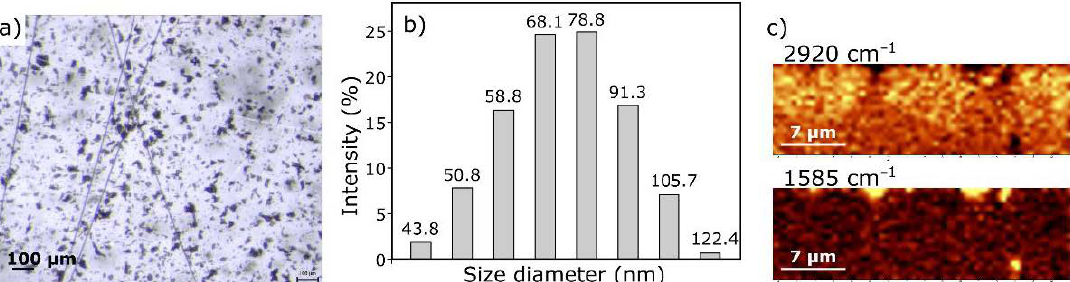
Figure 4. Microscopic photo ( a ), histogram of particle size distribution ( b ), and Raman images (the brighter the field, the greater the intensity) ( c ) of graphene oxide dispersed in epoxy